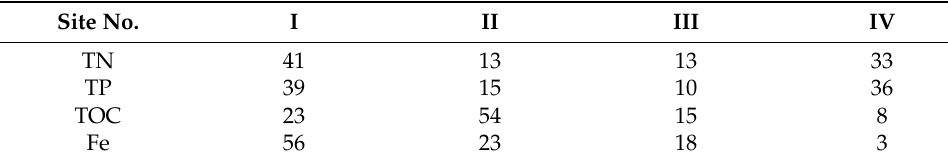
Figure 8. Spatial distribution of SPI for TN, TP, TOC and Fe. Table 6. SPI classes distribution for Warta River basin in